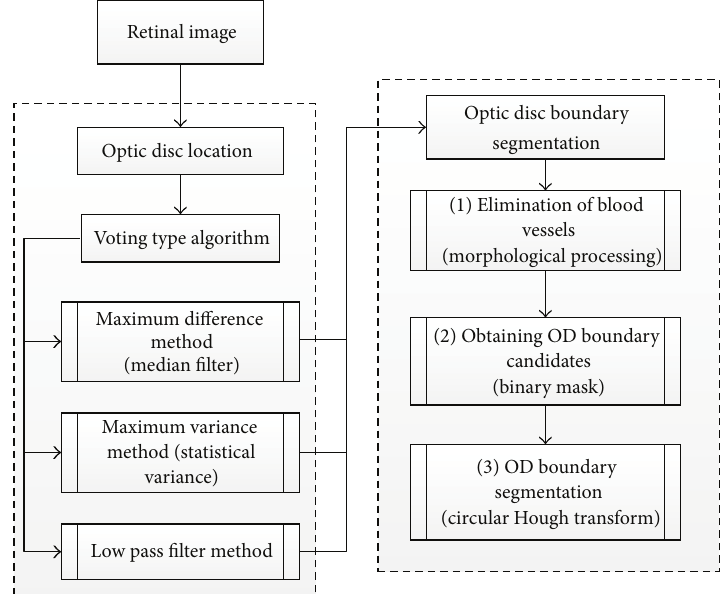
Figure 8: Flowchart for algorithm proposed in [32].